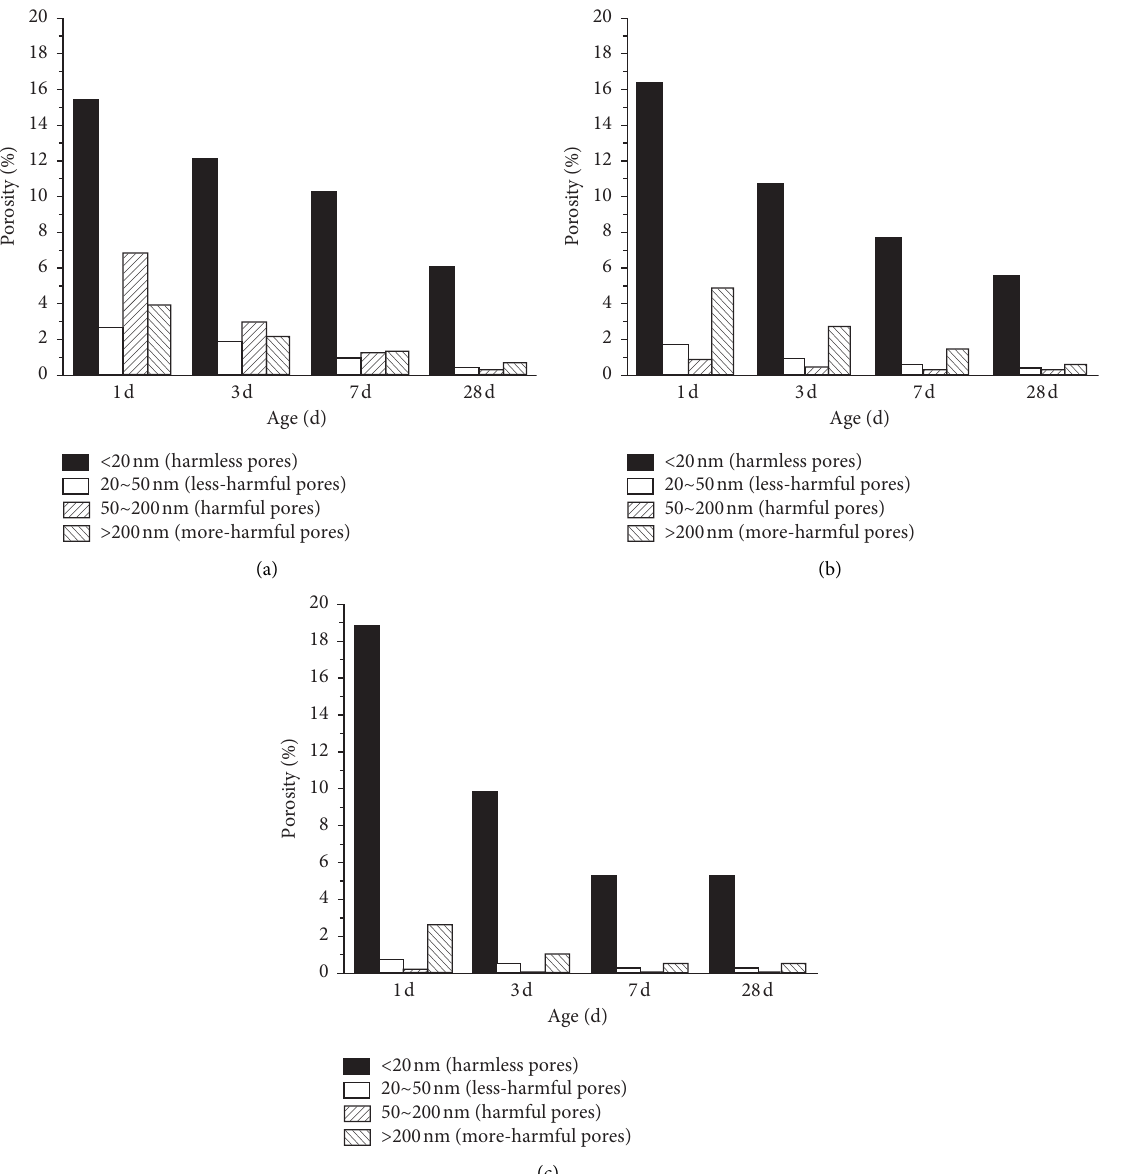
Figure 15: The porosity of pores at different sizes of alkali-activated nickel slags activated by different types of the alkali activator. (a) NS13- N2-J1. (b) NH8.52. (c)